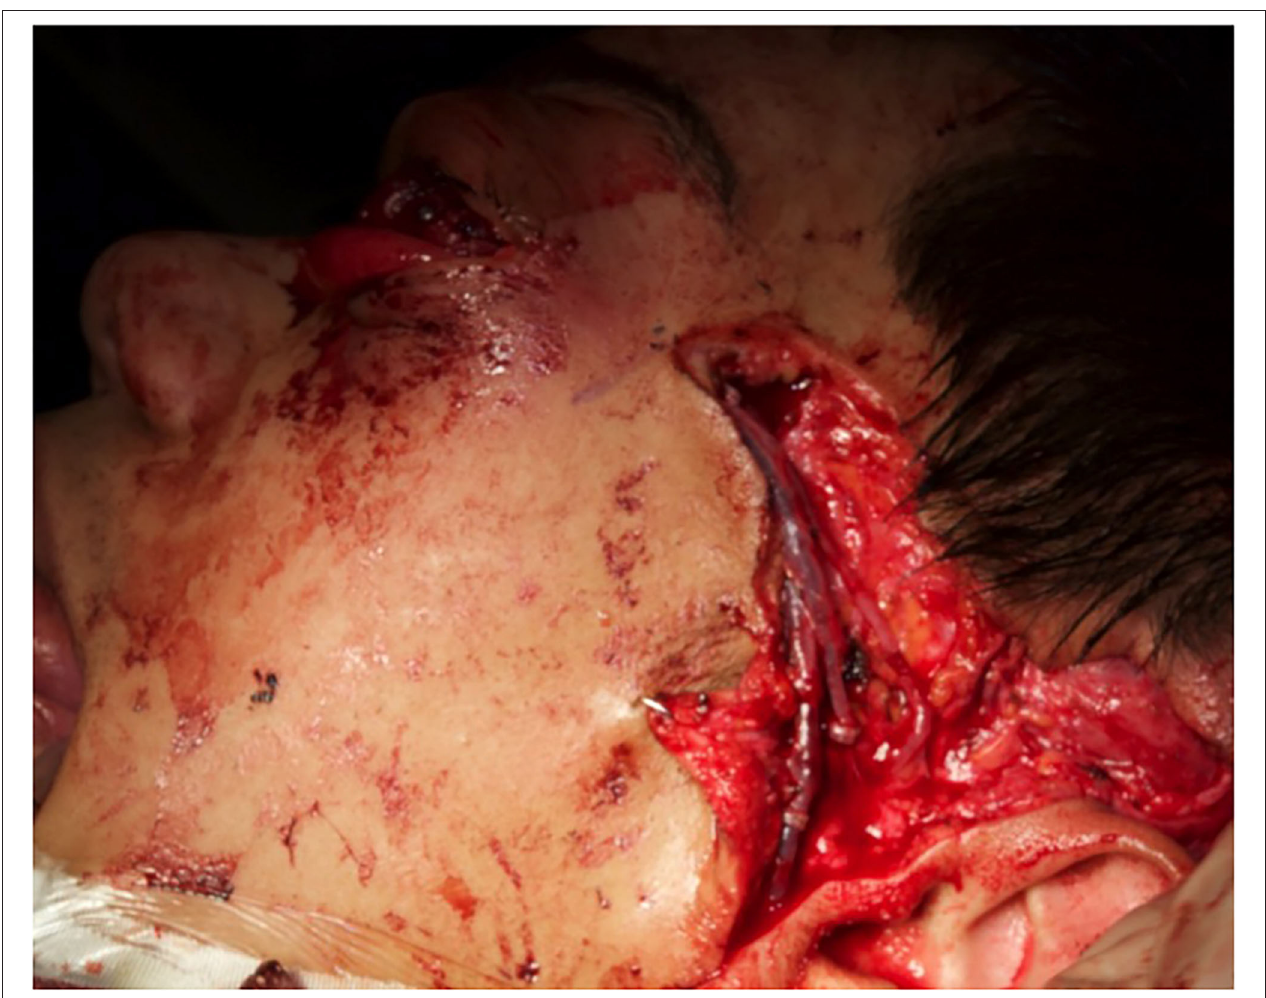
FIGURE 5 | The vastus lateralis free flap harvested with a muscle sparing technique and its inset. Note the pedicle, anastomosed on the temporal vessels, passed laterally to the external orbital frame through an incisura and brought to the temporal area through a subcutaneous